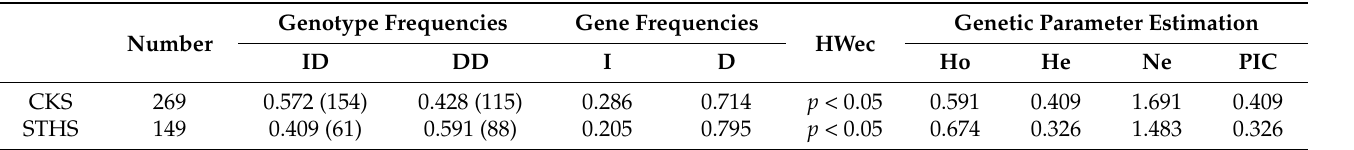
Table 2. Analysis of the InDel genetic parameters of the LRRC8B gene in Chaka sheep and Small- Tailed Han sheep.